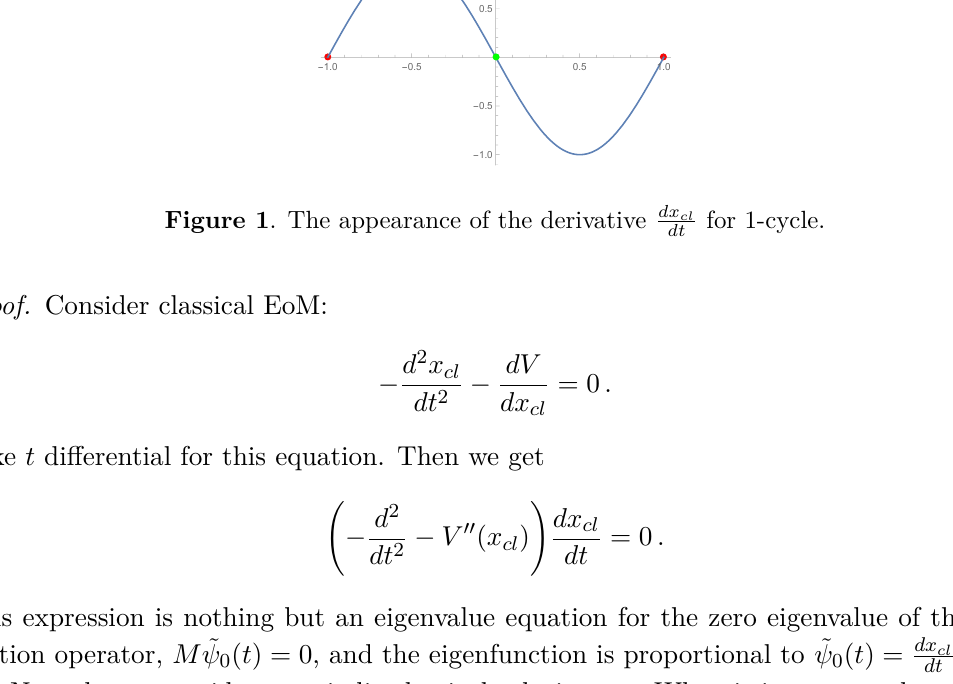
Figure 1 . The appearance of the derivative dx cl